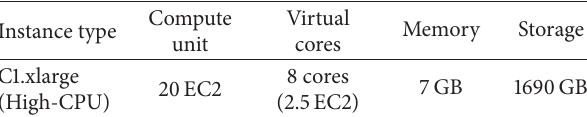
Table 1: Resource type